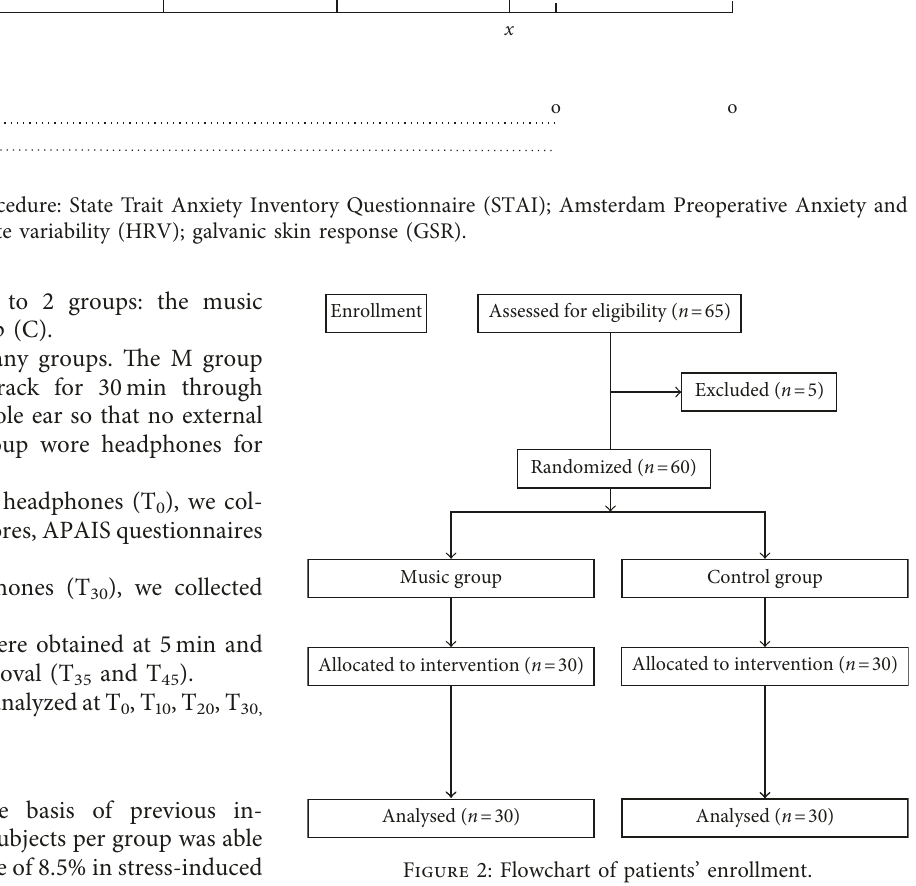
Figure 2: Flowchart of patients’